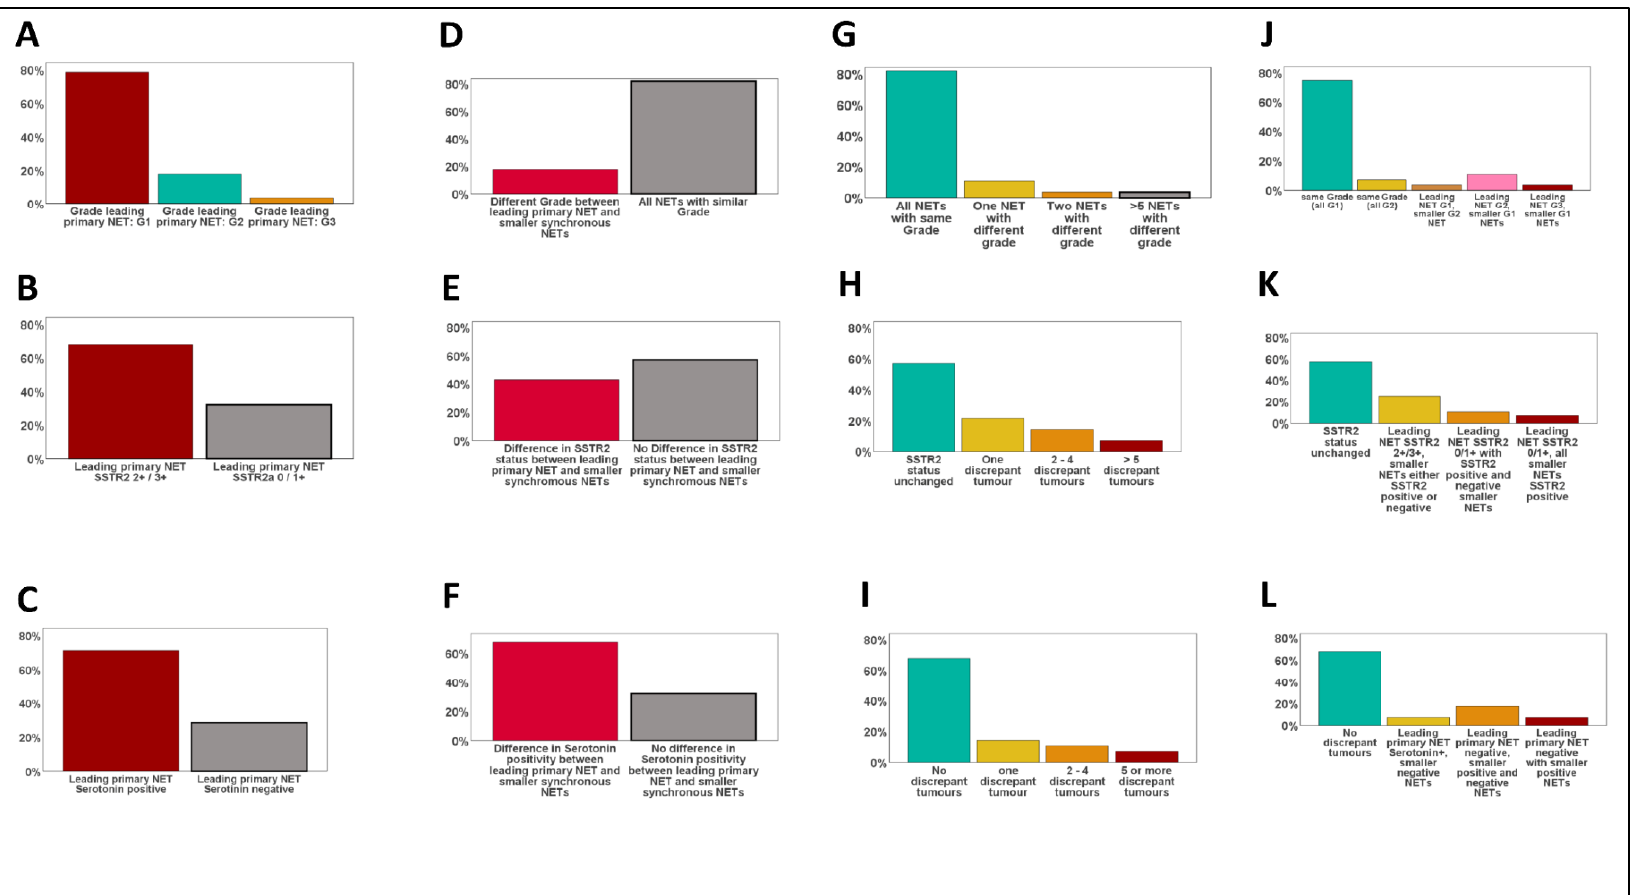
Figure 1. Heterogeneity of morphologic parameters in multifocal SI-NETs. ( A – C ): Frequency of WHO grades G1 – G3 ( A ) and SSTR2 expression groups ( B ) as well as serotonin expression within the leading primary NET. ( D – F ): Frequency of changes of WHO grade ( D ), SSTR2 expression ( E ), and serotonin positivity between the leading primary NETs and synchronous smaller NETs. ( G – I ): Number of divergent NETs compared to the leading primary for WHO grade ( G ), SSTR2 status ( H ), and serotonin expression ( I ). ( J – L ): Type of change between the leading primary NET and the smaller synchronous tumors for WHO grade ( J ), SSTR2 ( K ), and serotonin ( L